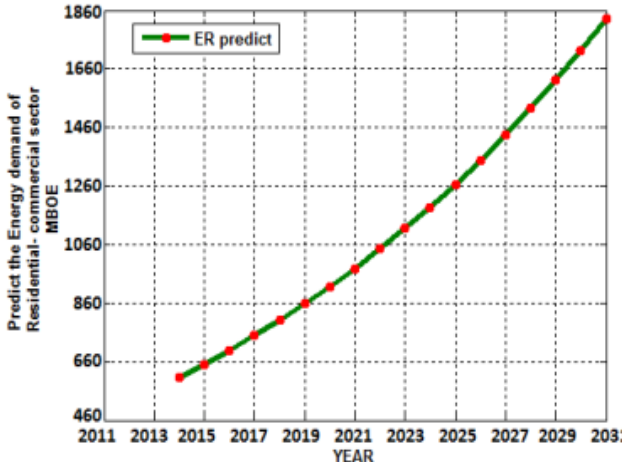
Fig. 4. The results of the proposed